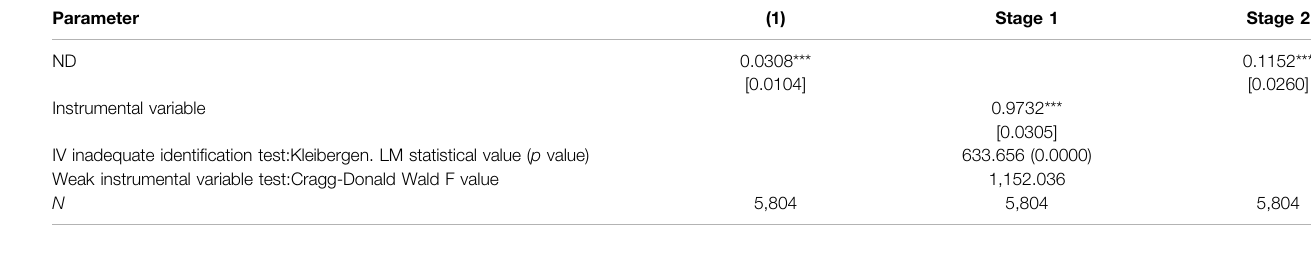
TABLE 3 | Estimation results of instrumental variables.